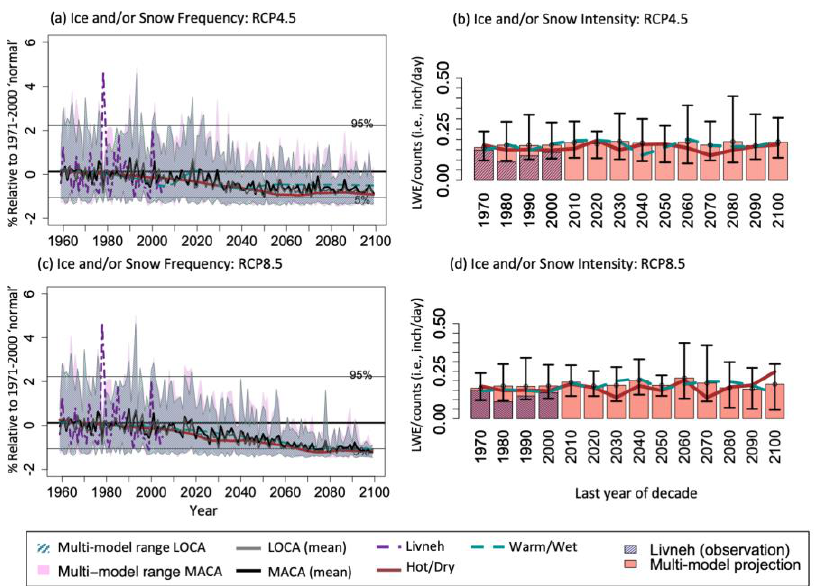
Figure 6. Historical and future climate model projections in winter precipitation (ice/snow) days and intensity. Panels ( a , c ) are time series of the standardized winter precipitation (ice/snow) frequency (days) for RCP4.5, and RCP8.5, respectively, while panels ( b , d ) depict decadal mean changes winter precipitation intensity for RCP4.5 and RCP8.5, respectively, defined as total accumulated winter precipitation divided by the number of events. For ( a , c ), the thin black line is the multi-model mean, and the solid (stippled) shading is the 5th to 95th percentile range from all MACA (LOCA) models. Observed (Livneh) data are the thick dashed line, and the 5th–95th percentile values of the observed data (1971–2000) are shown by the horizontal thin dashed black lines. For panels ( b , d ), the range bars depict the 5th–95th percentile range from all models. Observations are overlaid for the historical period. HD and WW scenarios are shown in all plots by the solid and dashed lines,